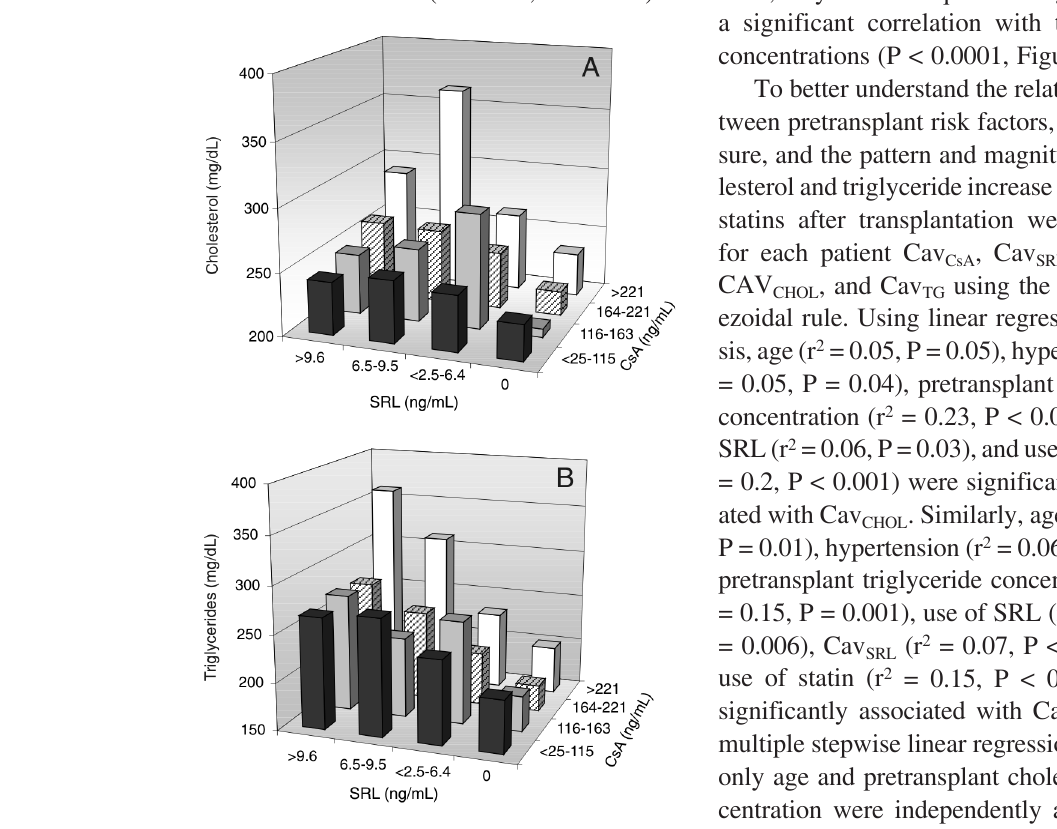
Figure 2. Combined effect of cyclosporin and sirolimus whole blood concentrations (according to